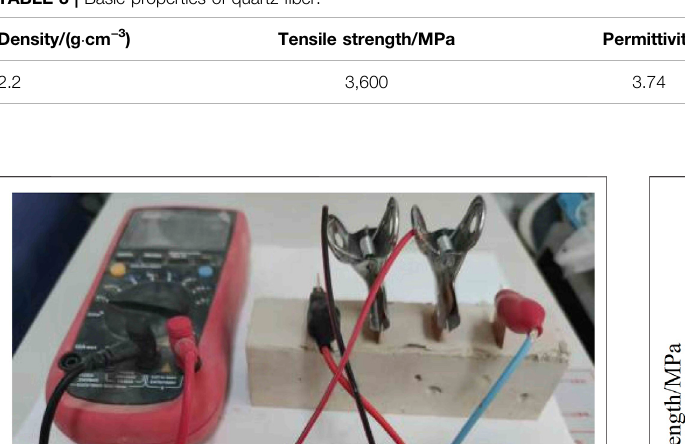
TABLE 3 | Basic properties of quartz fi ber.